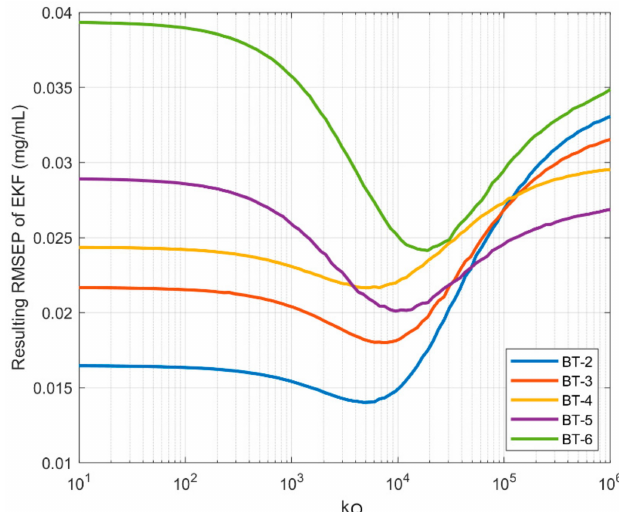
Figure 7. Error in the EKF prediction of the monoclonal antibody (mAb) concentration as a function of